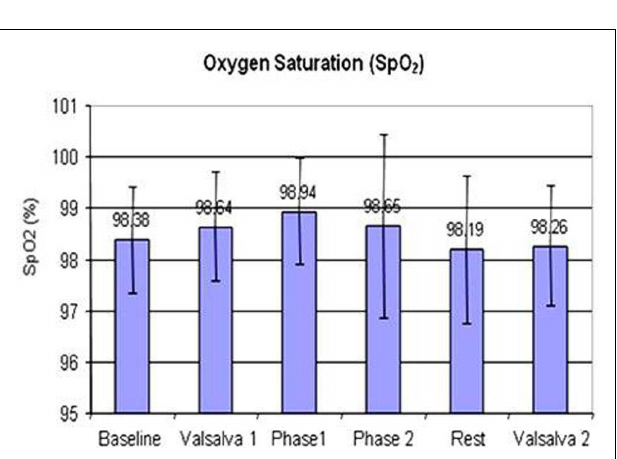
FIGURE 1 |The changes in systolic blood pressure (SBP) across the tasks.